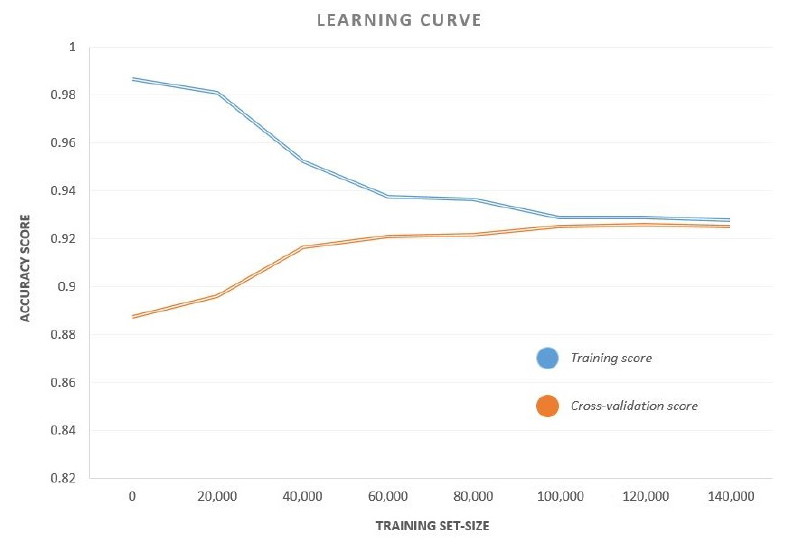
Figure 5. The Accuracy–Training Set Size Curve for the CB classifier. The curve plots the test accuracy for different training set sizes keeping the test set